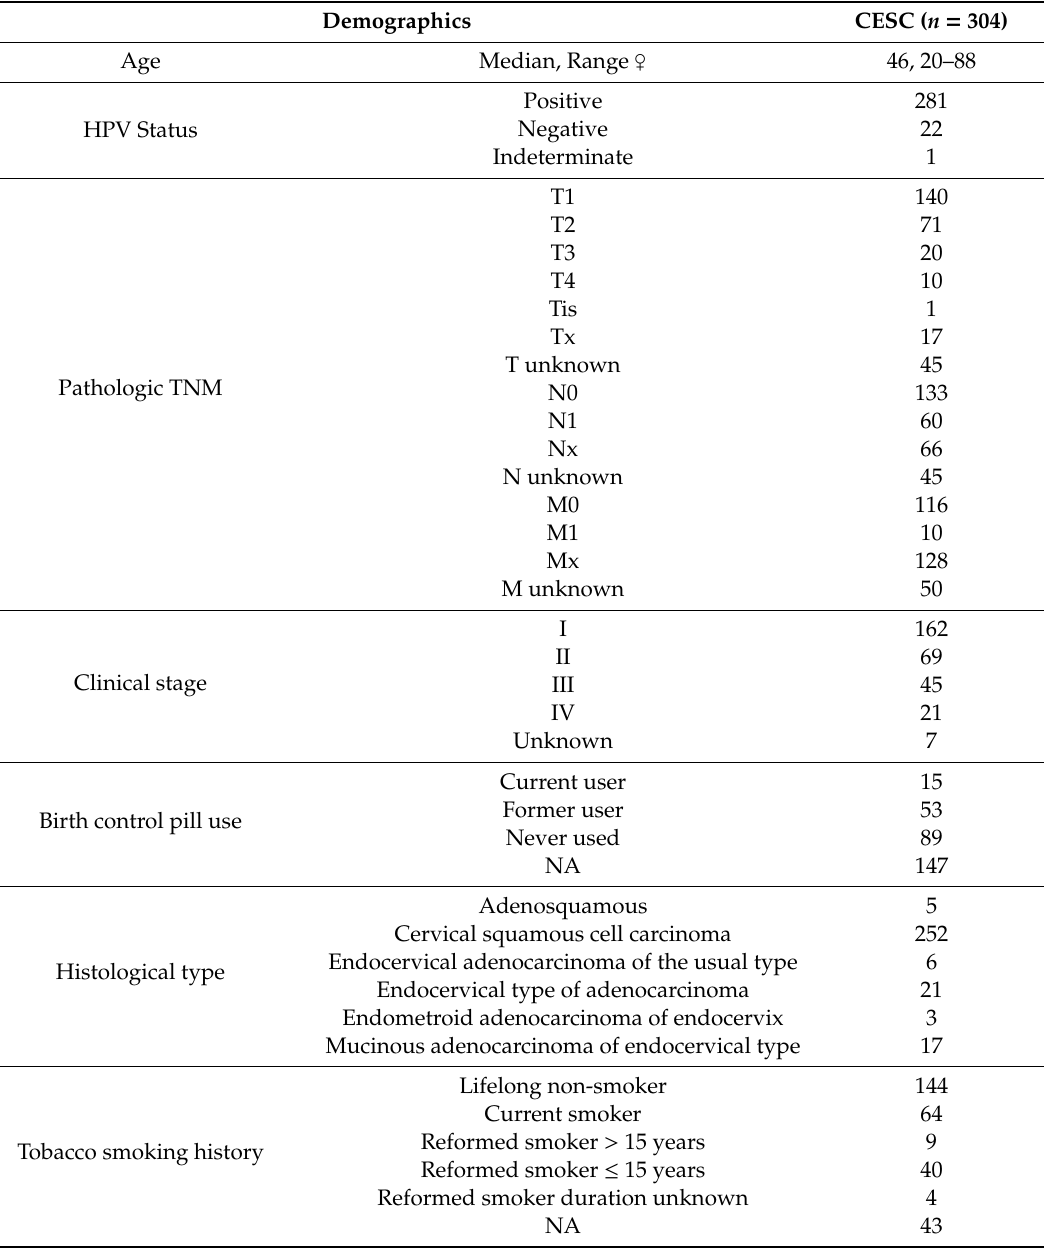
Table 3. Clinical data for cervical squamous cell carcinoma (CESC) patients